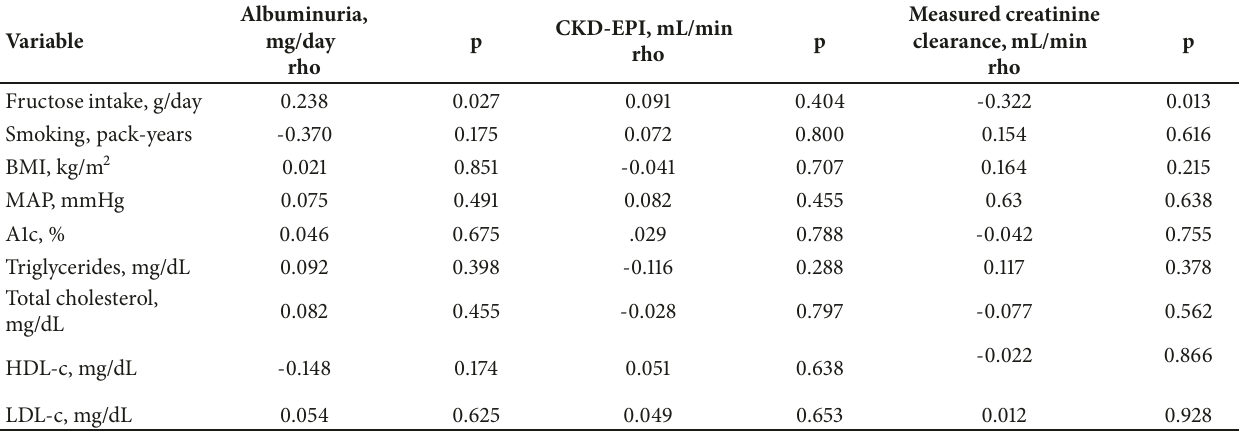
Table 4: Correlation analyses in subjects with albuminuria between 30 and 3500 g/day (n=86).